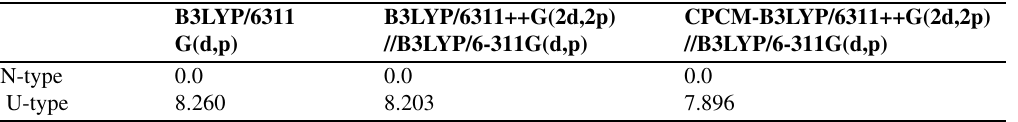
Table 2. The calculated relative energies of products Products Relative energy (kcal mol –1 )